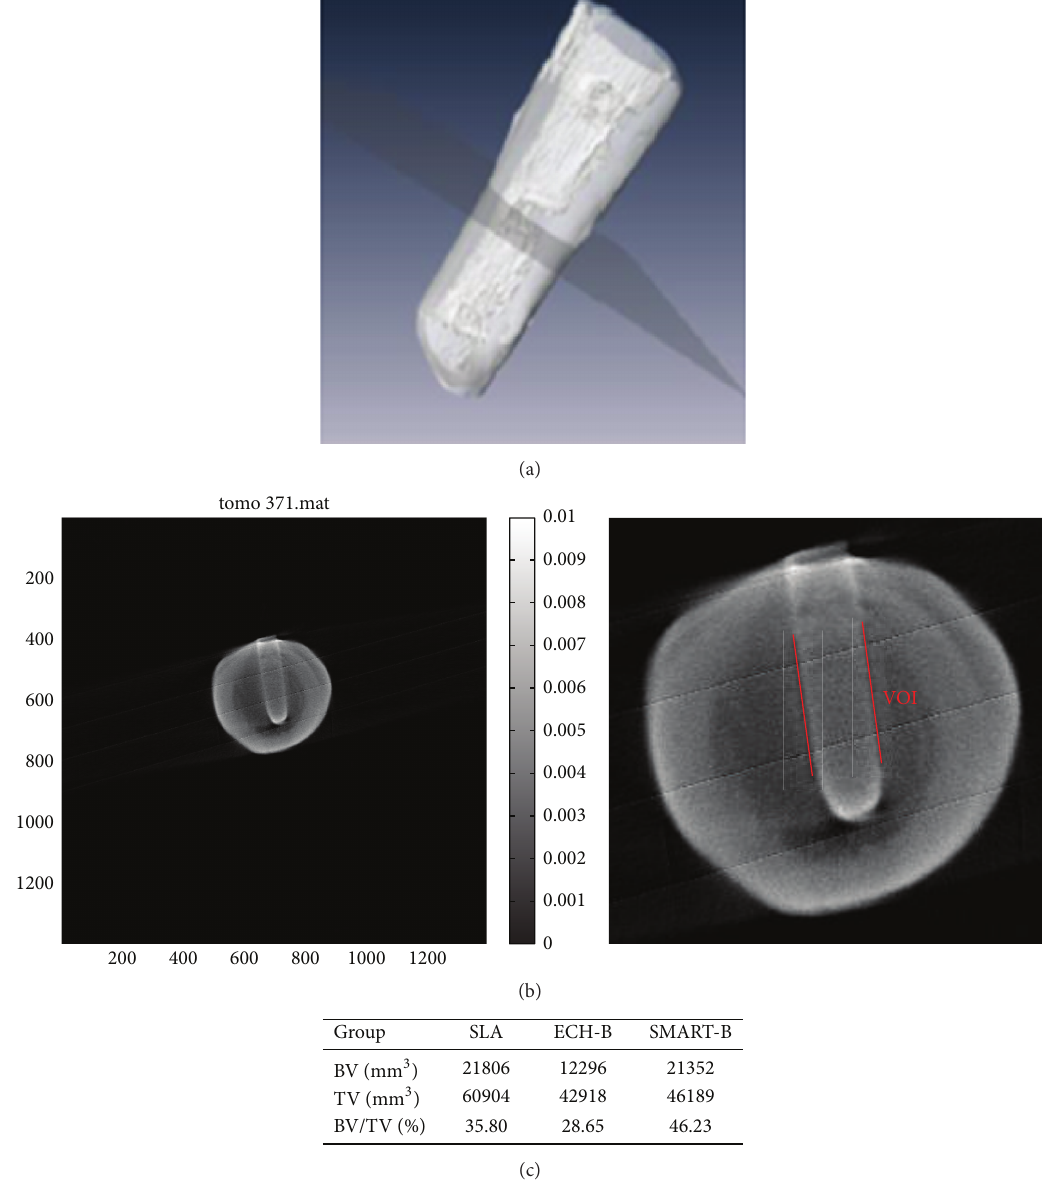
Figure 6: Bone quality evaluation at dental implant site by using micro-CT at 14 days. 3D image was observed using micro-CT (a) and the transverse section (b) was used to analyze the parameter of bone volume, total volume, and BV/TV (c) (ECH-B: ECH-BMP-2; SMART-B: